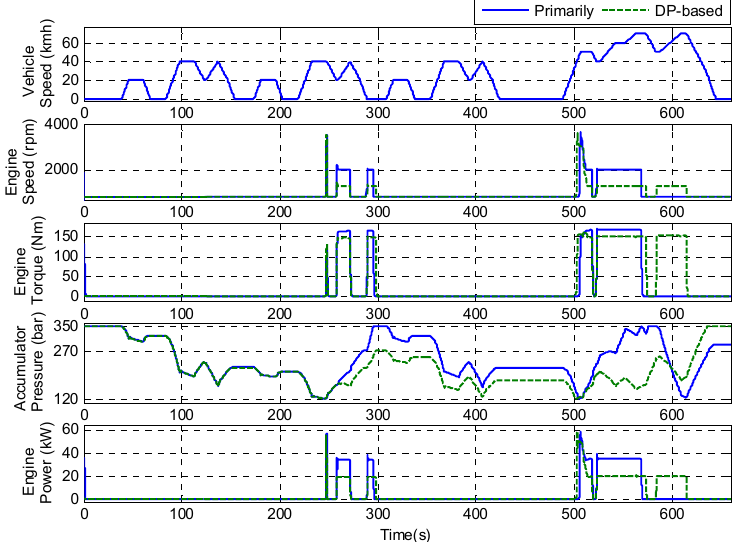
Figure 16. Pressure Trajectories with Primary and DP ‐ Based Thermostatic.